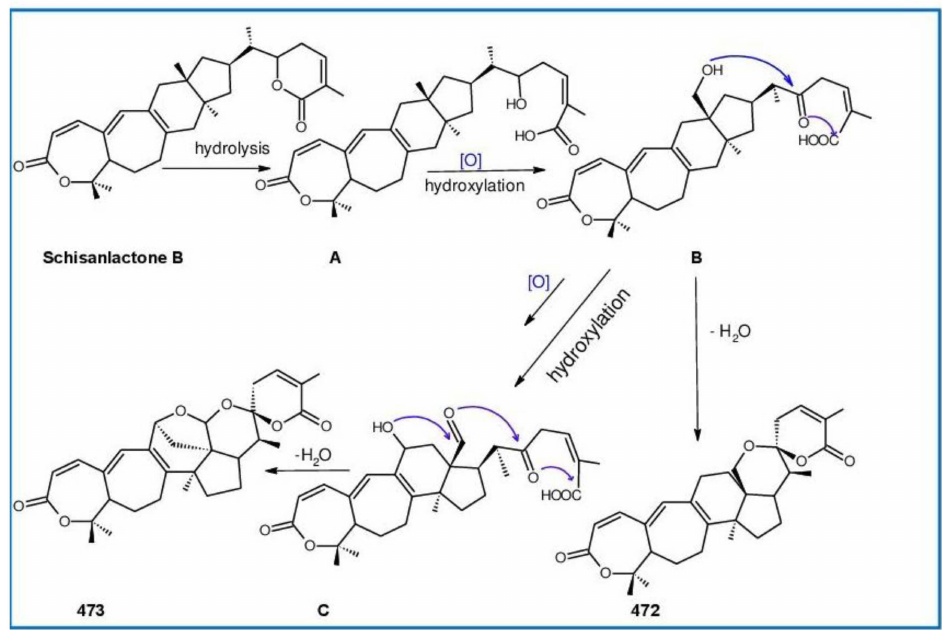
Figure 24. Possible biogenetic pathways for triterpenoid lactones ganodermalactones G ( 472 ) and F ( 473 ). Further bioactivity assay showed: (1) Colossolactone V ( 461 ), colossolactone VI ( 462 ) and colossolactone E ( 467 ) exhibited inhibitory activity against HIV-1 protease with IC 50 values of 9.0, >100 and 8.0 µ g/mL, respectively, El Dine 2008b [312]. (2) Colossolactone C ( 464 ), colossolactones D ( 466 ), E ( 467 ), F ( 468 ) and colossolactone G ( 471 ) showed mod- erate cytotoxicity against L-929, K-562 and HeLa cells with IC 50 values ranging from